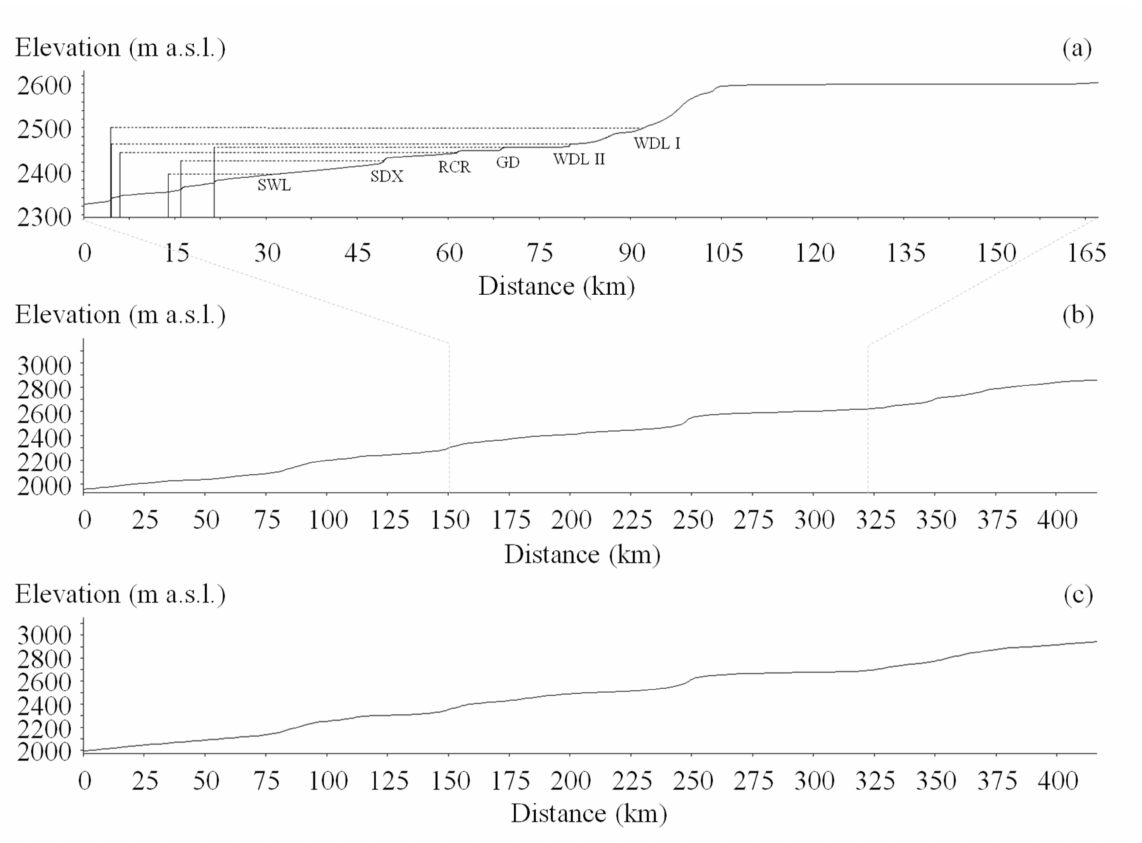
Figure 14. Fluvial response to river blocking dam. ( a ) is generated from ALOS 12.5 m DEM. ( b ) is generated from ALOS 12.5 m DEM in order to determine the scope of ( a , c ) which is generated from GDEMV2 30M as the control group of ( b